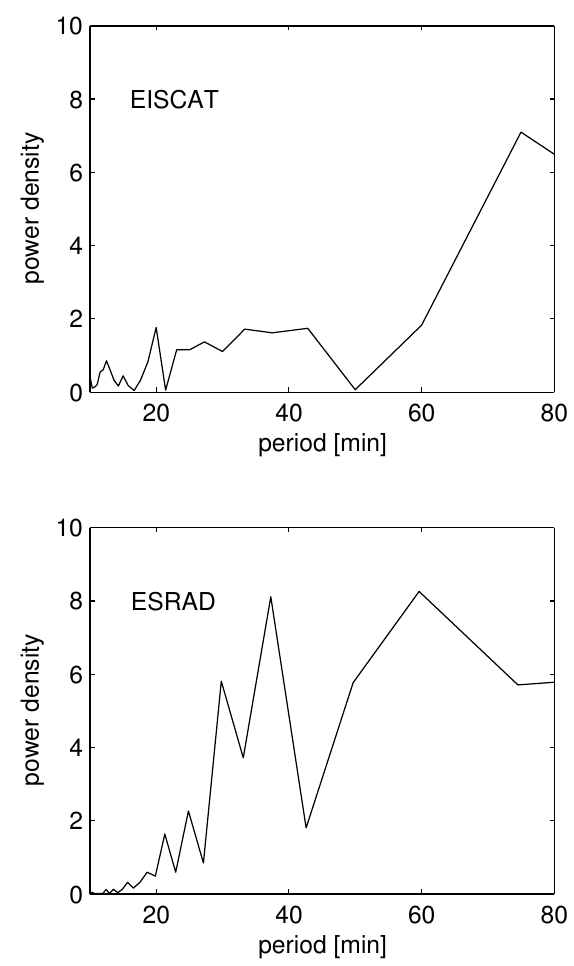
Fig. 2. Spectrum of the time variation of maximum signal strength in the PMWE layer between 06:30 and 11:30 UT (arbitrary